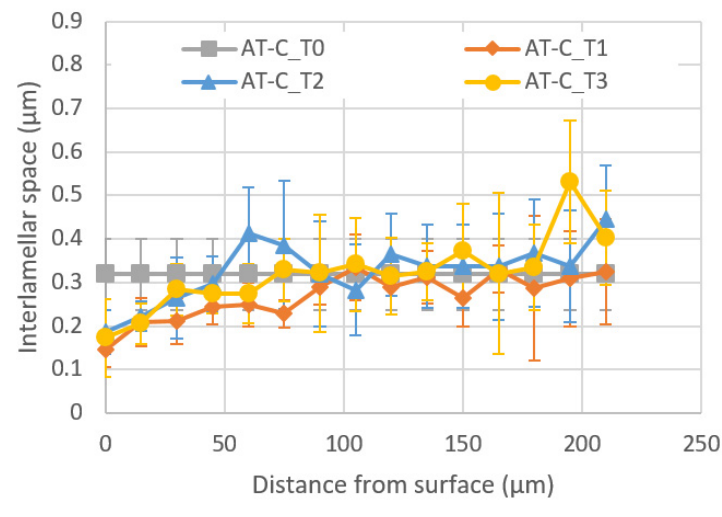
Figure 9. Evolution of interlamellar spacing with depth for Ring AT-C.